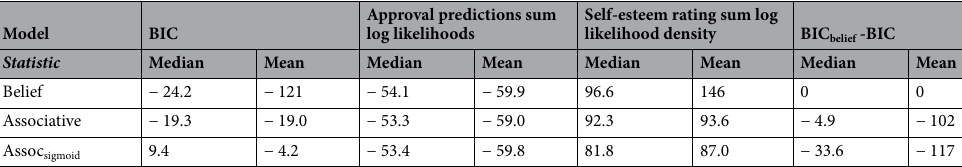
Table 3. Comparisons between the belief model, the associative model, and the associative model with sigmoid response function (assoc